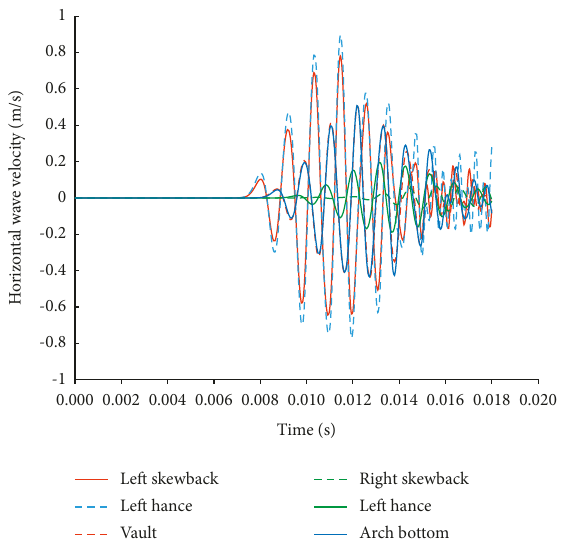
Figure 7: Time historic curve of wave velocity in different parts of tunnel.